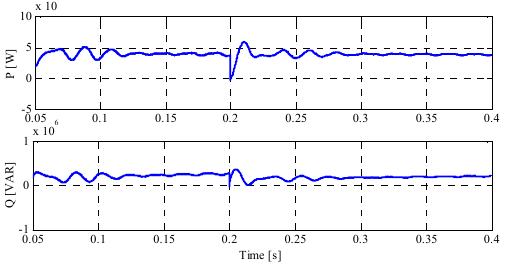
Figure 14. The active and reactive power of MMC with parameter variations.